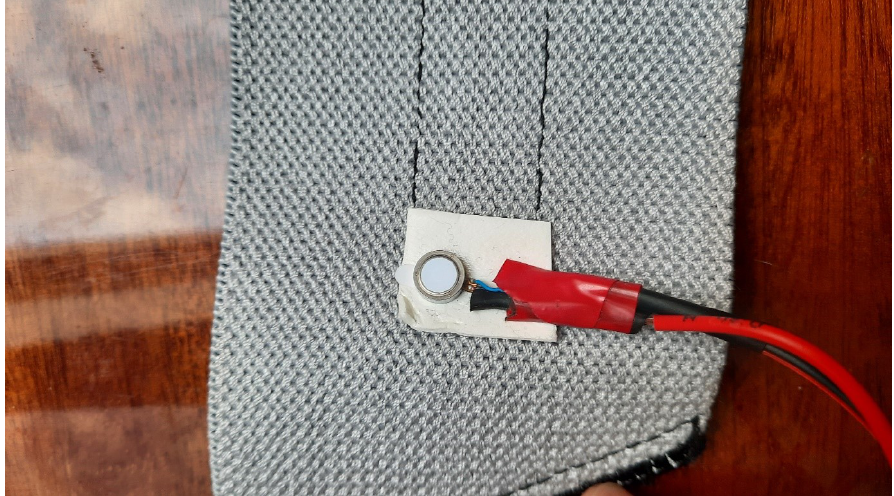
Figure 4. The vibrating motor fixed with double-sided